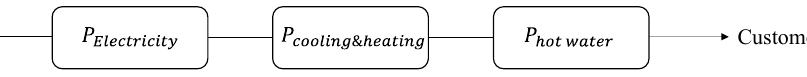
Figure 4. A simple customer-oriented reliability model of a CCHP system.